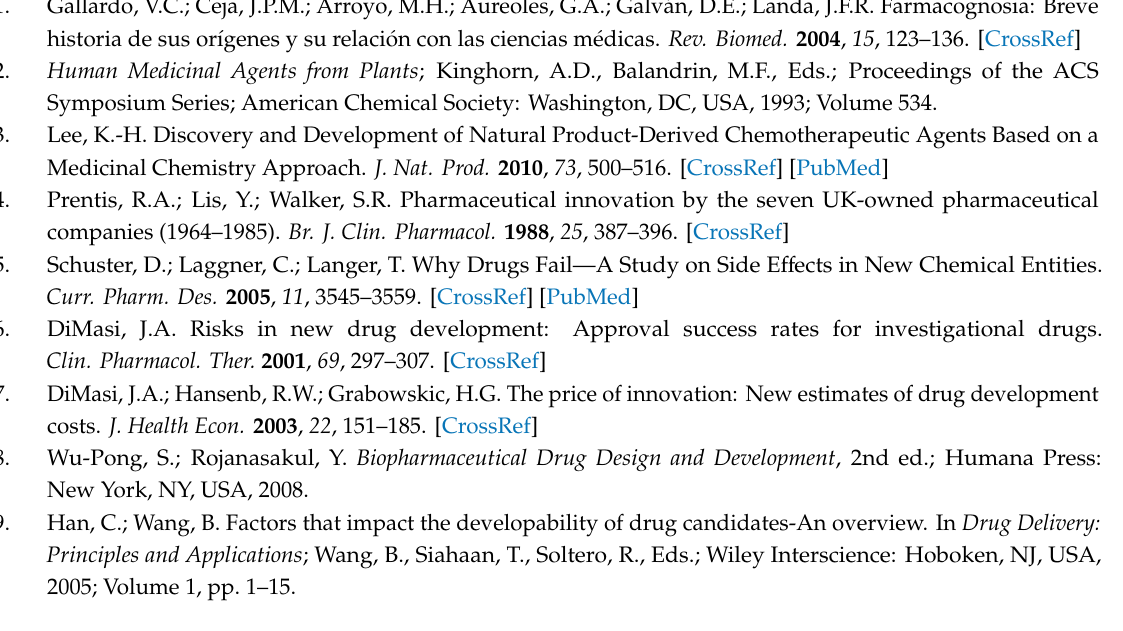
volumes, ∆ φ 0 , for aqueous solutions of ca ff eine in the presence of cyclodextrins at 298.15 K and 310.15 K; Table S20. V Thermodynamic properties of the complexation process of cyclodextrins with ca ff eine at 298.15 K and 310.15 K; Table S21. Coe ffi cients A and B of the Jones-Dole equation and transfer ∆ B coe ffi cients of the aqueous solutions of ca ff eine in the presence of cyclodextrins at 298.15 K and 310.15 K; Table S22. Ternary mutual di ff usion coe ffi cients D 11 , D 12 , D 21 and D 22 for aqueous β -CD (1) + ca ff eine (2) solutions and respective standard deviations, S D , at 298.15 K and 310.15 K; Table S23. Ternary mutual di ff usion coe ffi cients D 11 , D 12 , D 21 and D 22 for aqueous HP- β -CD (1) + ca ff eine (2) solutions and respective standard deviations, S D , at 298.15 K and 310.15 K; Table S24. Values of K and D 33* estimated from the ternary di ff usion coe ffi cients of ca ff eine aqueous solutions in the presence of β -CD at 298.15 K and 310.15 K; Table S25. Values of K and D 33* estimated from the ternary di ff usion coe ffi cients of aqueous solutions of ca ff eine in the presence of HP- β -CD at 298.15 K and 310.15 K; Table S26. Densities, viscosities and apparent molar volumes for theophylline + β -CD + water ternary systems at various concentrations at 298.15 K and 310.15 K; Table S27. Densities, viscosities and apparent molar volumes for theophylline + HP- β -CD + water ternary systems at various concentrations at 298.15 K and 310.15 K; Table S28. Partial molar volumes, φ 0 , and V partial molar transfer volumes, ∆ φ 0 , for aqueous solutions of theophylline in the presence of cyclodextrins at V 298.15 K and 310.15 K; Table S29. Thermodynamic properties of the complexation process of cyclodextrins with theophylline at 298.15 K and 310.15 K; Table S30. Coe ffi cients A and B of the Jones-Dole equation and transfer ∆ B coe ffi cients for the aqueous solutions of theophylline in the presence of cyclodextrin at 298.15 K and 310.15 K; Table S31. Ternary mutual di ff usion coe ffi cients D 11 , D 12 , D 21 and D 22 for aqueous β -CD (1) + theophylline (2) solutions and respective standard deviations, S D , at 298.15 K and 310.15 K; Table S32. Ternary mutual di ff usion coe ffi cients D 11 , D 12 , D 21 and D 22 for aqueous HP- β -CD (1) + theophylline (2) solutions and respective standard deviations, S D , at 298.15 K and 310.15 K; Table S33. Values of K and D 33* estimated from the ternary di ff usion coe ffi cients of the aqueous solutions of theophylline in the presence of β -cyclodextrin at 298.15 K and 310.15 K; Table S34. Values of K and D 33 * estimated from the ternary di ff usion coe ffi cients of the aqueous solutions of theophylline in the presence of HP- β -cyclodextrin at 298.15 K and 310.15